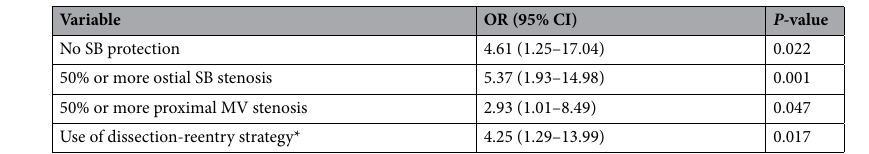
Table 5. Independent predictors of side branch occlusion. CI confidence interval, MV main vessel, OR odds ratio, SB side branch. *Includes both antegrade and retrograde